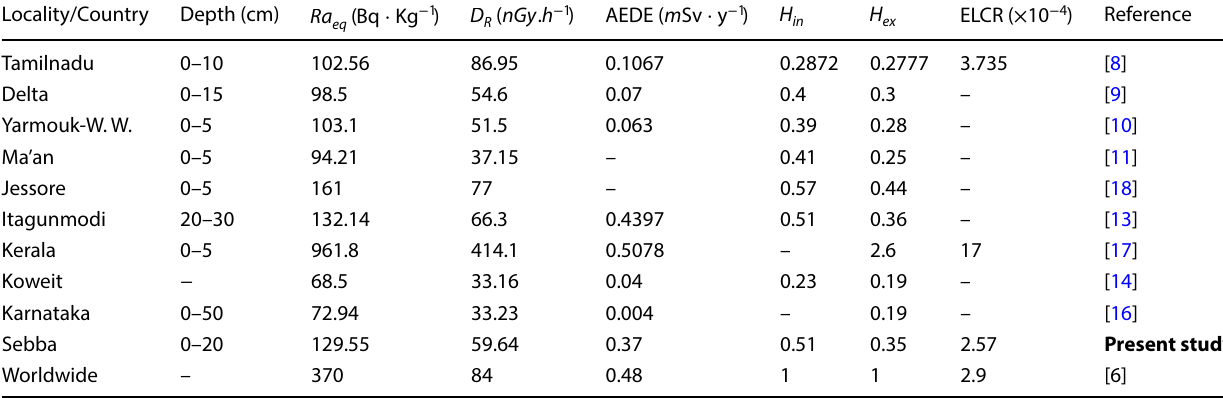
Table 5 Radiation hazard indices measured worldwide